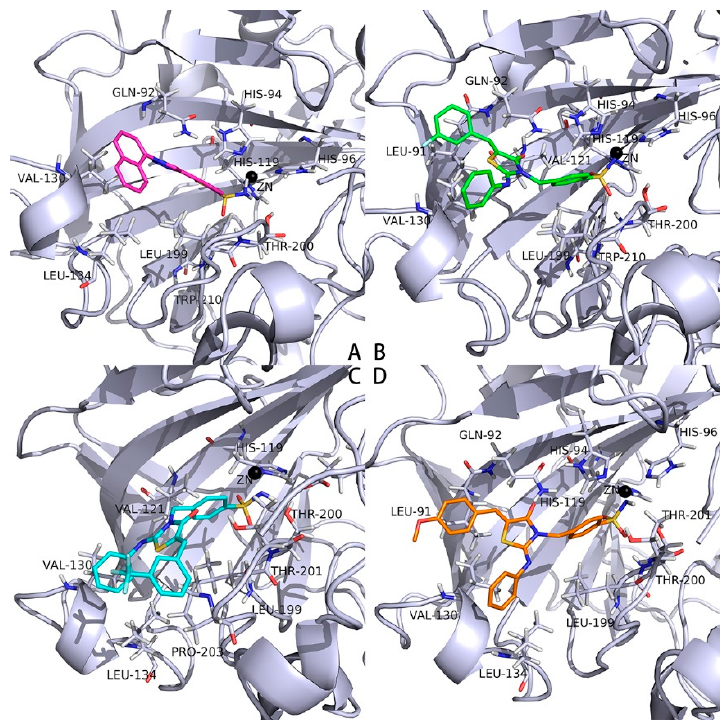
Figure 2. The study of binding mode within CA IX. ( A ) 5FL4-ref (pink) ( B ) compound ( 4 ) (green) ( C ) compound ( 7 ) (cyan) ( D ) compound ( 11 ) (khaki).